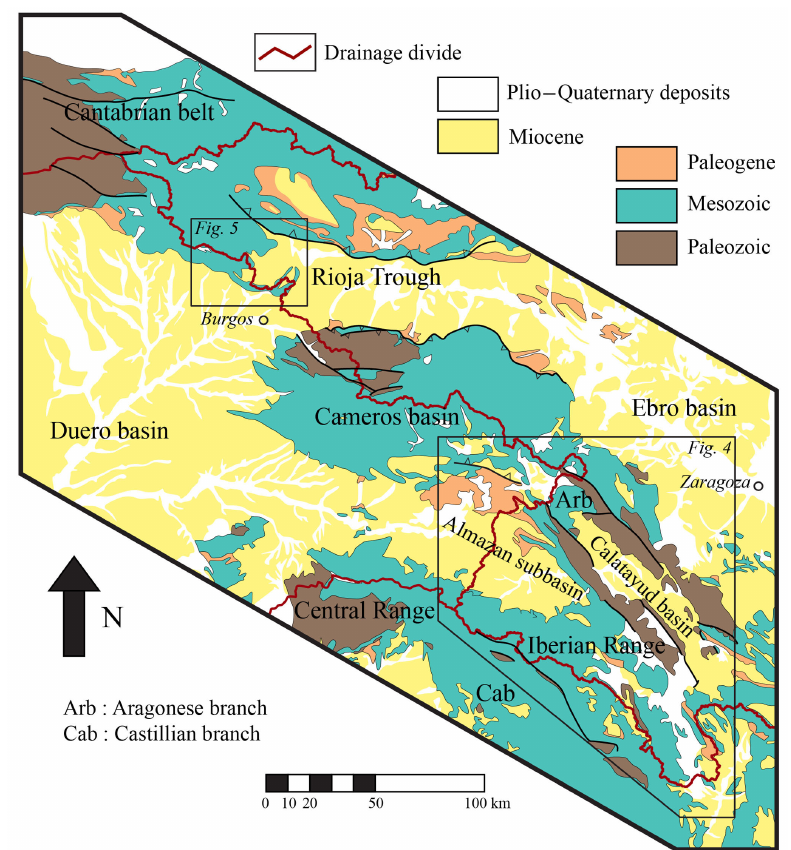
Figure 2. Simplified geological map of the study